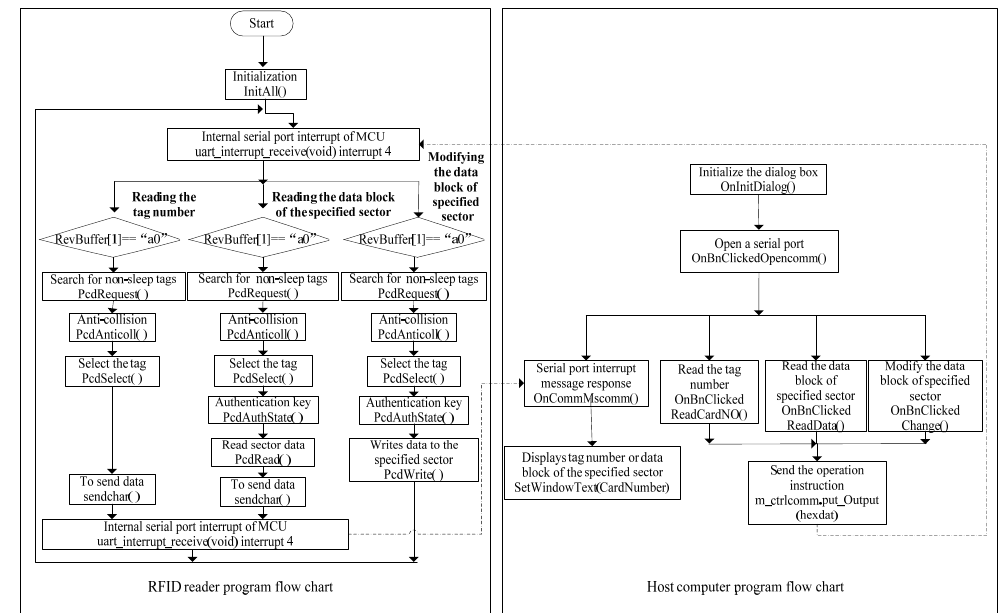
Figure 8. The flow chart of the communication function between RFID reader and host computer.